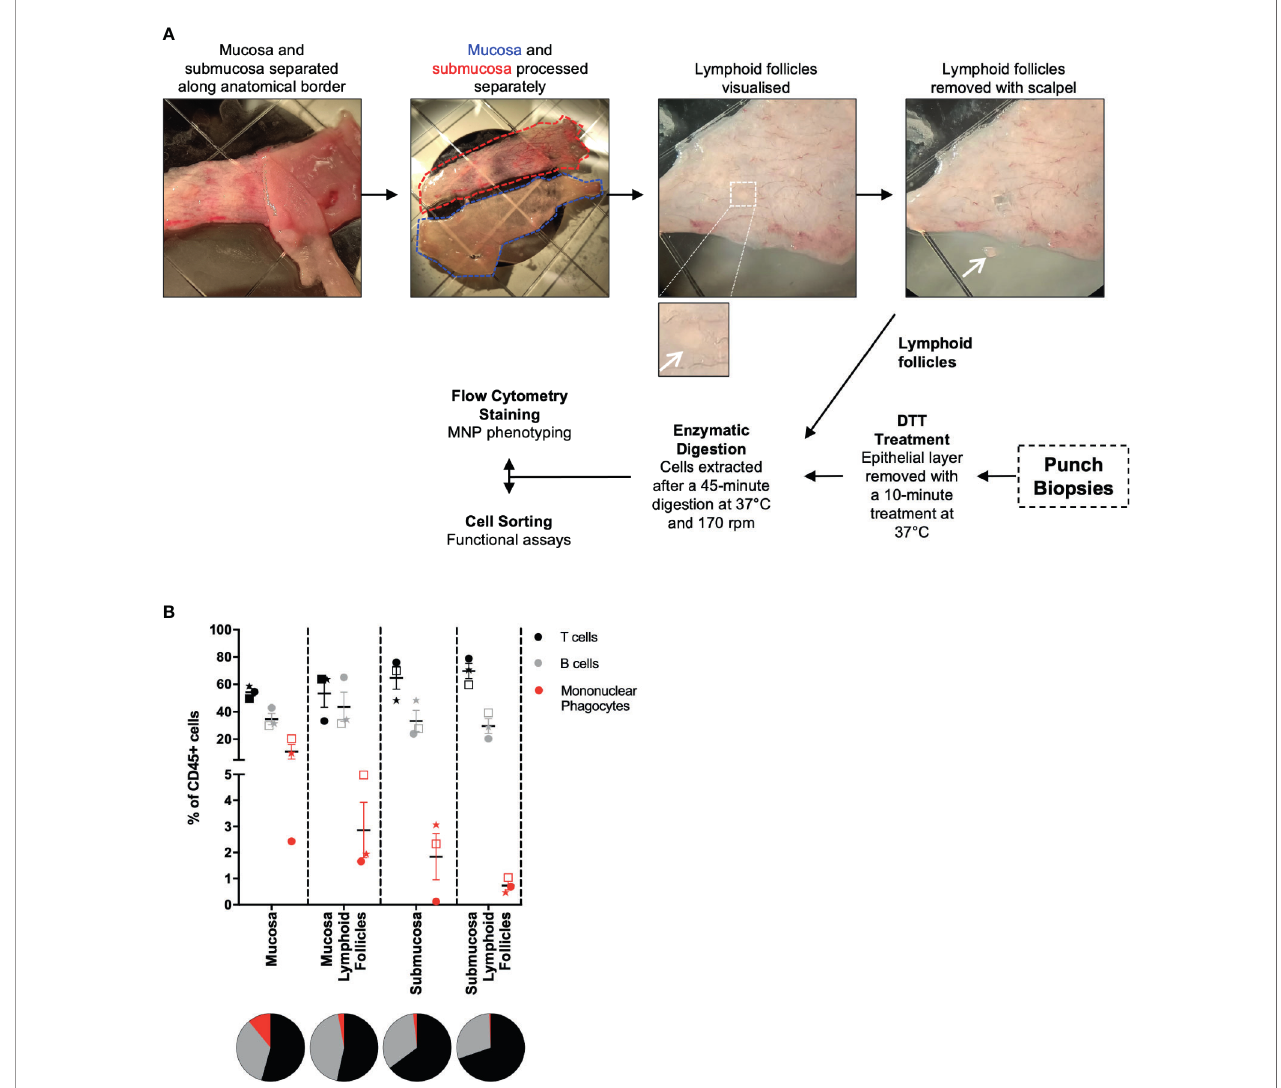
FIGURE 2 | Separation of tissue compartments from intestinal tissue. Discarded human intestinal tissues were obtained and underlying tissue removed as in Figure 1 . (A) Under a dissecting microscope, the mucosa and submucosa were mechanically separated with forceps. Mucosa and submucosa were then processed separately for the removal of lymphoid follicles. Insert: magni fi ed view of a lymphoid follicle. Follicles are visualised and removed from each tissue layer using a scalpel. Mucosa and submucosa were processed as per Figure 1 , with no DTT treatment for the submucosa. Lymphoid follicles were digested for 45 mins at 37°C at 170 rpm. When obtained, punch biopsies were DTT-treated for 10 mins at 37°C, before being digested as per the lymphoid follicles. (B) Cells liberated from tissue compartments were analysed by fl ow cytometry. CD3 + T cells, CD19 + B cells and HLA-DR + mononuclear phagocytes were represented as a percentage of CD45 + cells with mean ± SEM. Each symbol represents an individual donor (n=3). Pie charts represent the mean as parts of